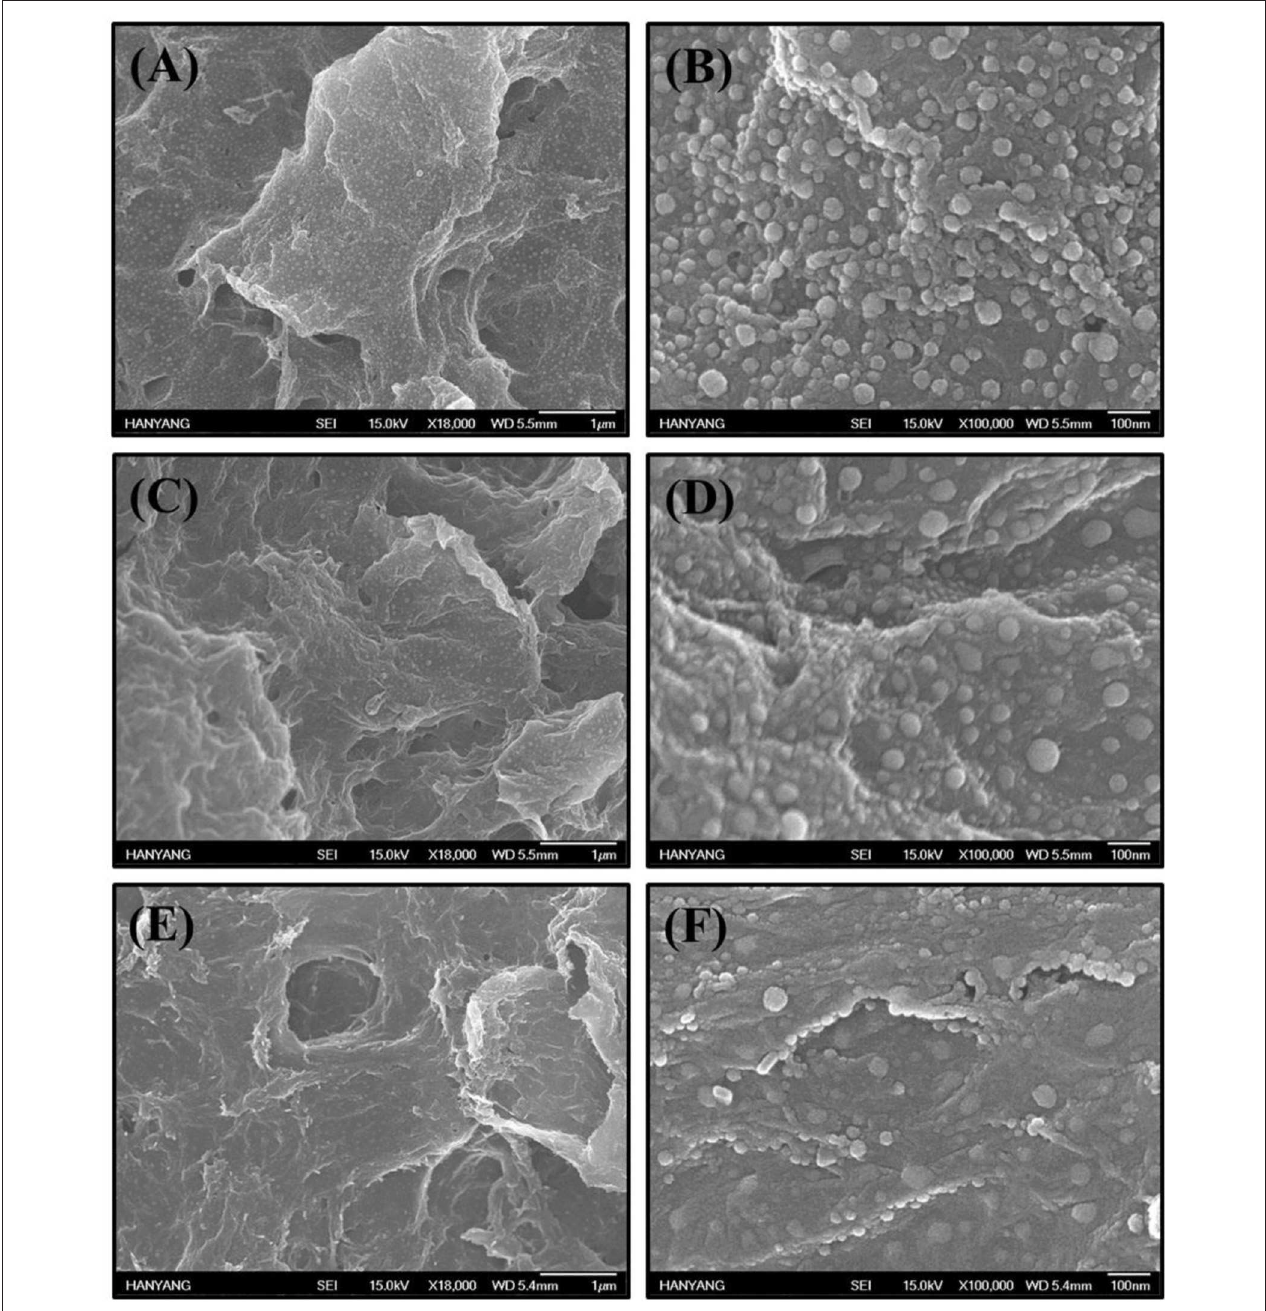
FIGURE 3 | (A,B) SEM images of Pd-RGO-0, (C,D) Pd-RGO-100, and (E,F) Pd-RGO-500.